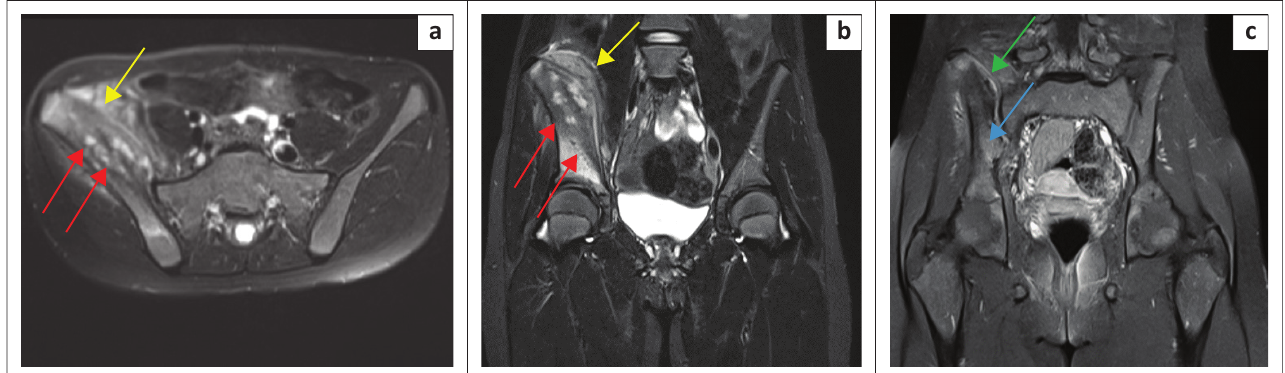
FIGURE 2: Magnetic resonance imaging of the pelvis performed without and with gadolinium: (a) Axial T2 fat-saturated image of the pelvis showing heterogeneous marrow signal within the right iliac wing with marrow expansion (red arrows). Diffuse layered periosteal reaction was noted with increased T2 signal in the adjacent part of the iliacus and gluteal muscles (yellow arrow). (b) Coronal short tau inversion recovery (STIR) image of the pelvis showing layers of periosteal reaction (yellow arrow). Increased marrow signal could be seen extending close to the acetabular roof but without intra-articular extension (red arrows). (c) Coronal fat-saturated image gadolinium enhanced T1 weighted image indicated mild sacroiliitis with post contrast enhancement (green arrow) and heterogeneous marrow enhancement (blue arrow). In addition, there was enhancement of the adjacent